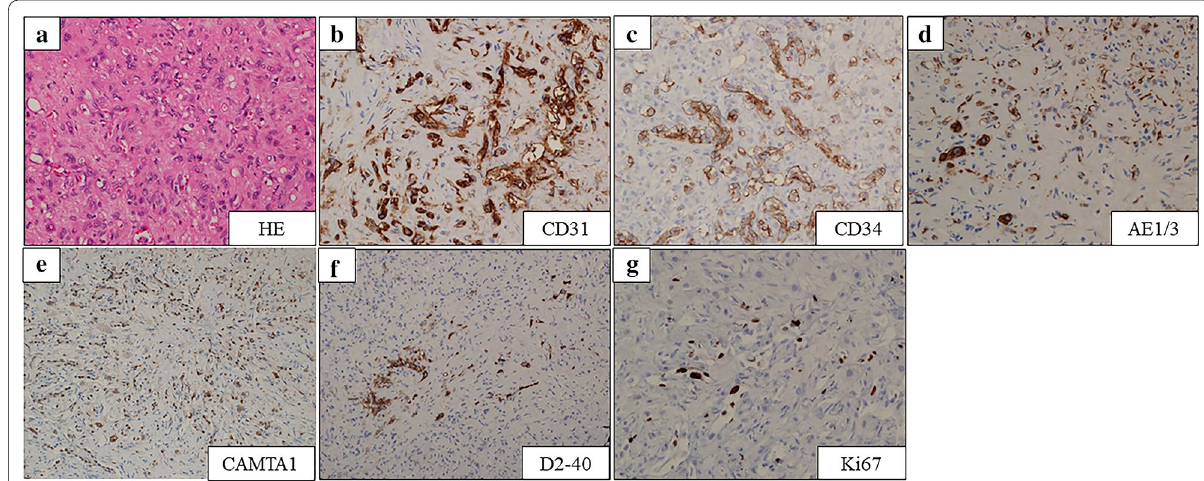
Fig. 3 a Pathological evaluation of the liver biopsy showed proliferation of acidophil tumor cells surrounded by a fibromyxoid stroma ( b – g Immunohistochemical staining showed strong expression of CD31 ( b , expression of D2-40 ( f ,